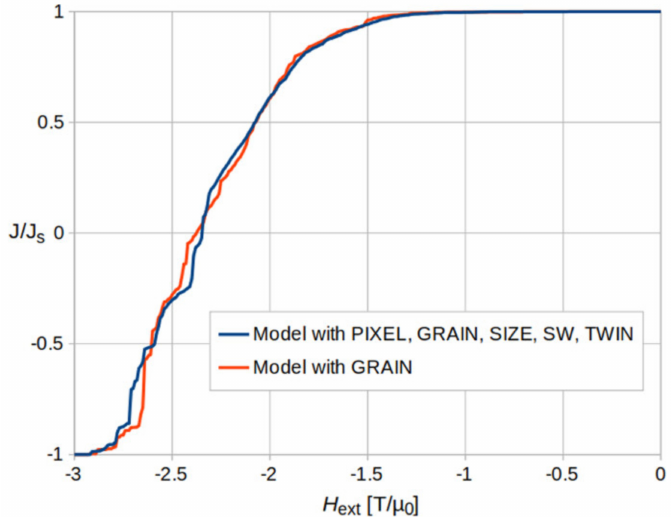
Figure 6. Examples of magnetization curves of Mn-Al-C PM implementing distinct models [22].